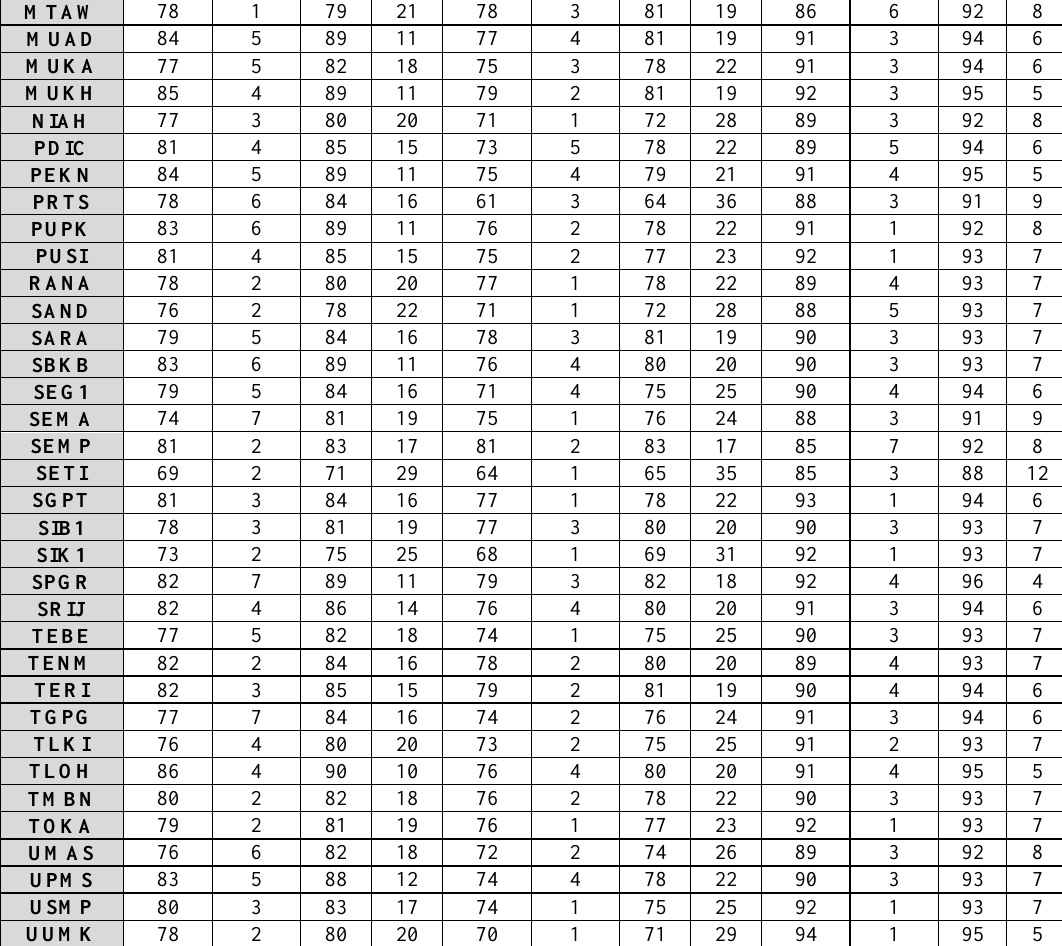
Table 2. The percentage of presence of earth body tide (EBT), ocean tide loading (OTL), earth tide (ET) and other signals (OT) in GPS